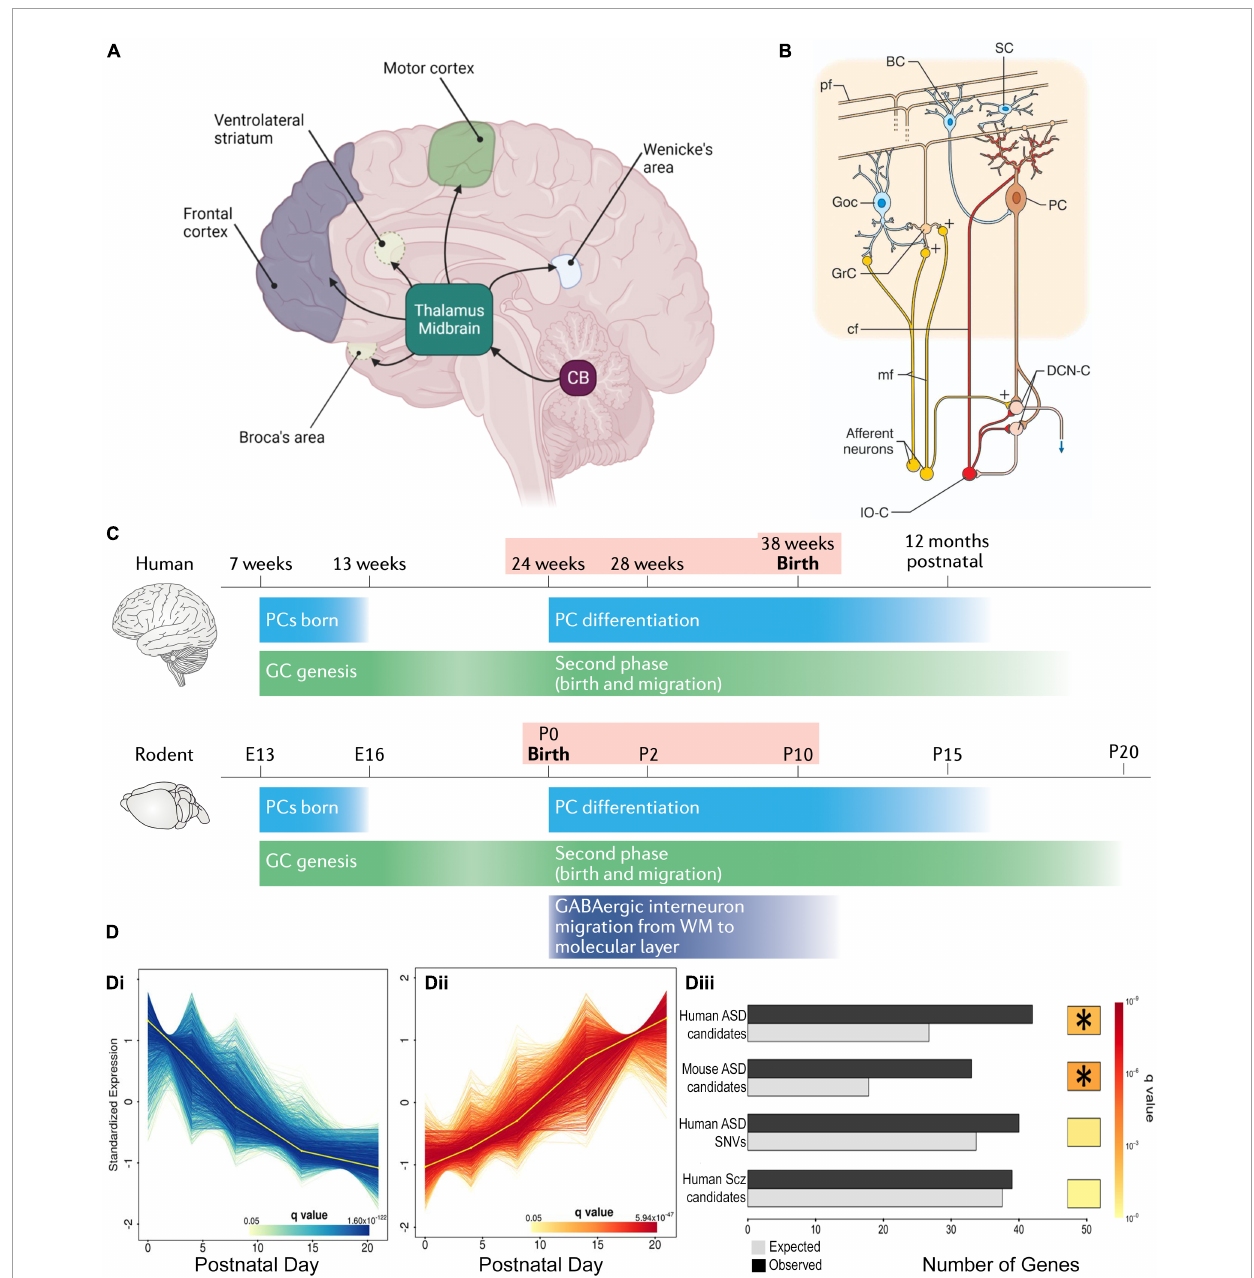
FIGURE1 Cerebellar connectivity and development underlies its link to NDDs. (A) The cerebellum has extensive connectivity with the forebrain via the thalamus which underlie its many cognitive and affective roles that are concentrated in different regions. Reproduced with permission from Hatten (2020). (B) Cerebellar cortical circuitry, in which Purkinje cells (PCs) integrate signals from olivary climbing fibers (cf) and granule cell (GrC) parallel fibers (pf), which have received cortical information via pontine mossy fibers (mf), in order to modify deep cerebellar nuclear (DCN) activity, which in turn projects back to the cortex. Neuronal responses are modulated by GABAergic interneurons: feedforward inhibition through basket (BC) and stellate (SC) cells to PCs, and feedback inhibition of GrC-pf activity by Golgi cells (GoC). Reproduced from D’Angelo and Casali (2013) with permission. (C) Humans and rodents have a relatively similar time-course of events leading to cerebellar development, although the human brain inevitably takes longer. Both human and rodent cerebella have relatively similar prolonged vulnerability (pink shading) around birth. Reproduced